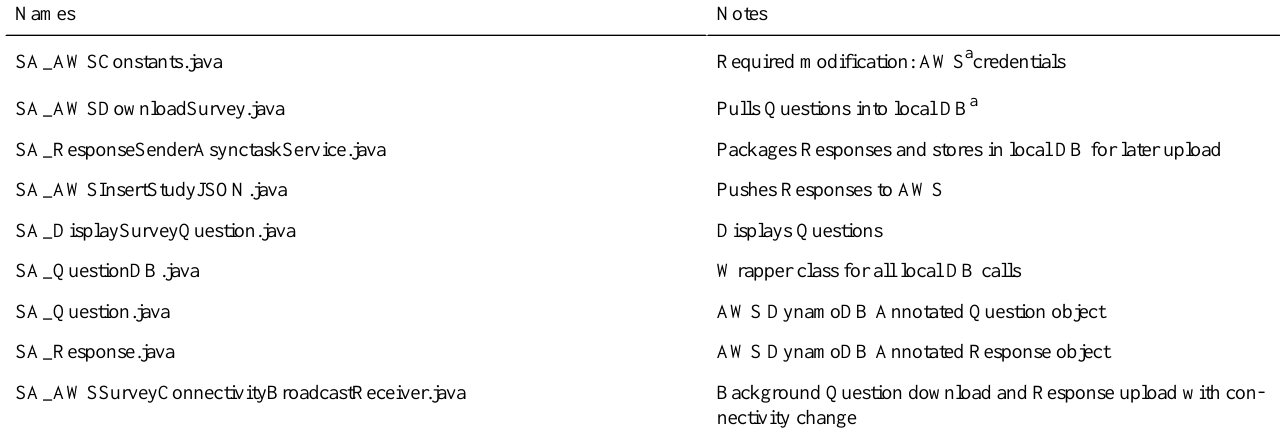
Table 2. Core Survalytics Java classes.